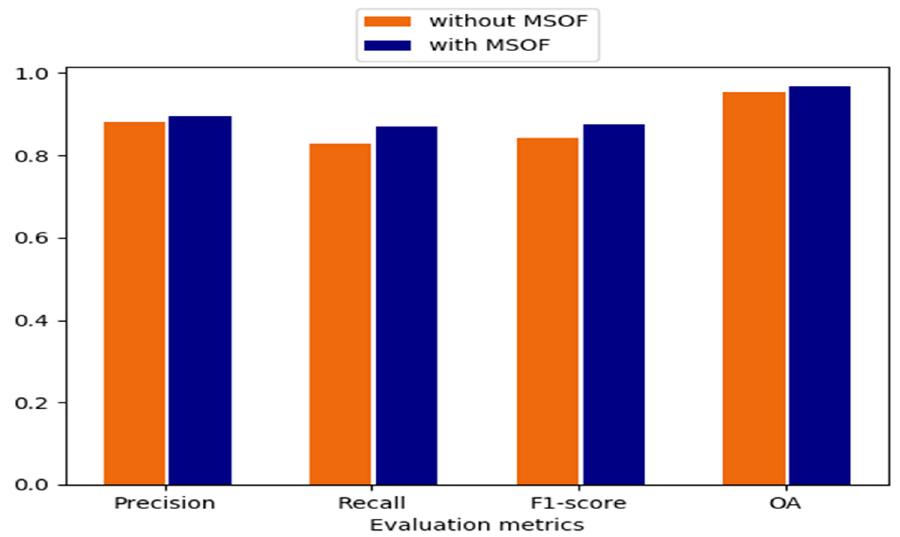
Figure 6. The effect of multiple side-outputs fusion (MSOF) strategy on the accuracy of our proposed CD method in terms of Precision, Recall, F1-score, and OA.